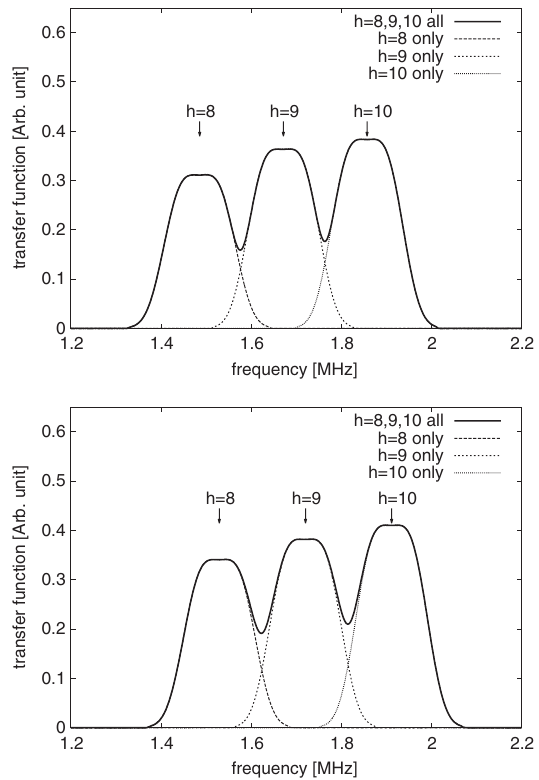
FIG. 11. Transfer functions of the feedforward system #8 after commissioning: (top) injection period; and (bottom) near ex-